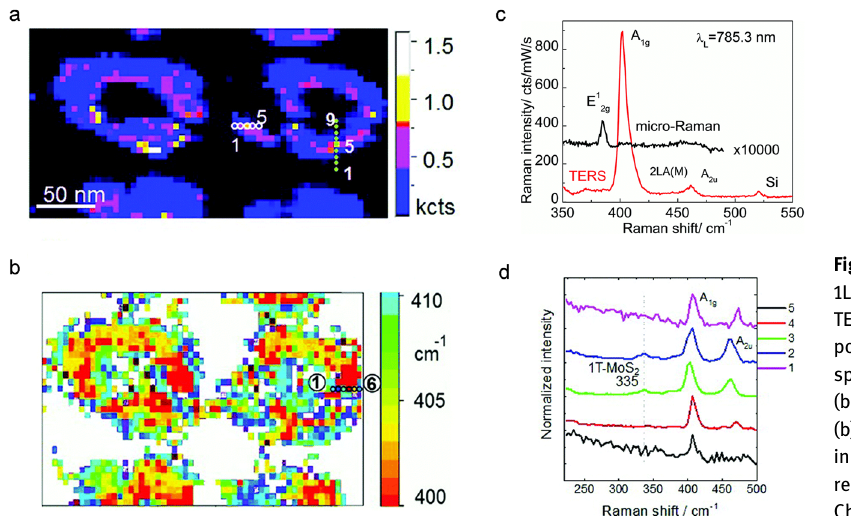
(vdW) contact, where d < ∼ 0.5 nm, the quantum plasmonic effect of the charge tunneling between the tip and the sample surface tends to suppress the near- fi eld enhance- ment [138 – 140]. Zhang et al. fi rst demonstrated the TERS of few-layer MoS on a gold substrate under vdW contact be- 2 tween thetipandsample( d < ∼ 0.36nm),calledthequantum coupling region, as shown in Figure 12a [141]. At a tip- sample distance of 2 < d < 10 nm, which is called the classic coupling region, the PL and Raman signals increase owing to the near- fi eld enhancement. By contrast, in the quantum region, both the PL and Raman signals were saturated at a